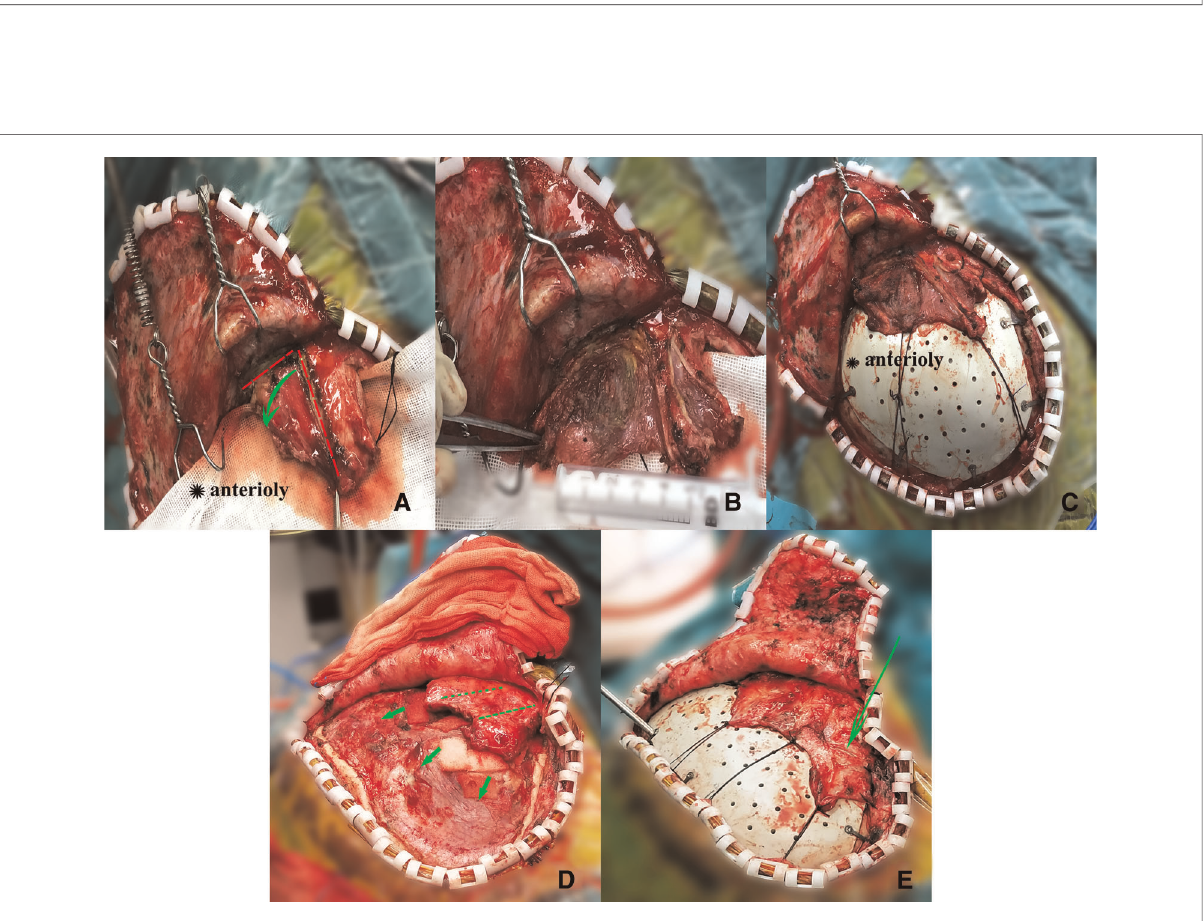
FIGURE 2 ( A – C ) An illustrative case. A 40-year-old female with frontotemporoparietal cranial defect due to brain trauma and her temporal muscle was hypertrophic. ( A ) The L-shaped incision (red dashed line) was made using monopolar coagulator with the depth deeper than the temporalis fascia and along the super fi cial layer of the muscle. The super fi cial muscle layer along with the fascia layer was dissected using the scissors and the green arrow indicates that the two layers were re fl ected anterosperiorly. ( B ) Re fl ection of the two layers of the temporalis anterosperiorly to mimic the muscle ’ s original anatomy. ( C ) The temporal muscle is fi xed onto the titanium mesh plates or the dissected periosteum using sutures to sustain its tension. ( D,E ) A 33-year-old male with cranial defect after intracranial hematoma and his temporal muscle performs fl at. ( D ) The straight-line incisions made along the super fi cial temporal fascia. ( E ) The green arrow indicated that the incisions made along the fascial and the extended temporalis is fi xed using the same